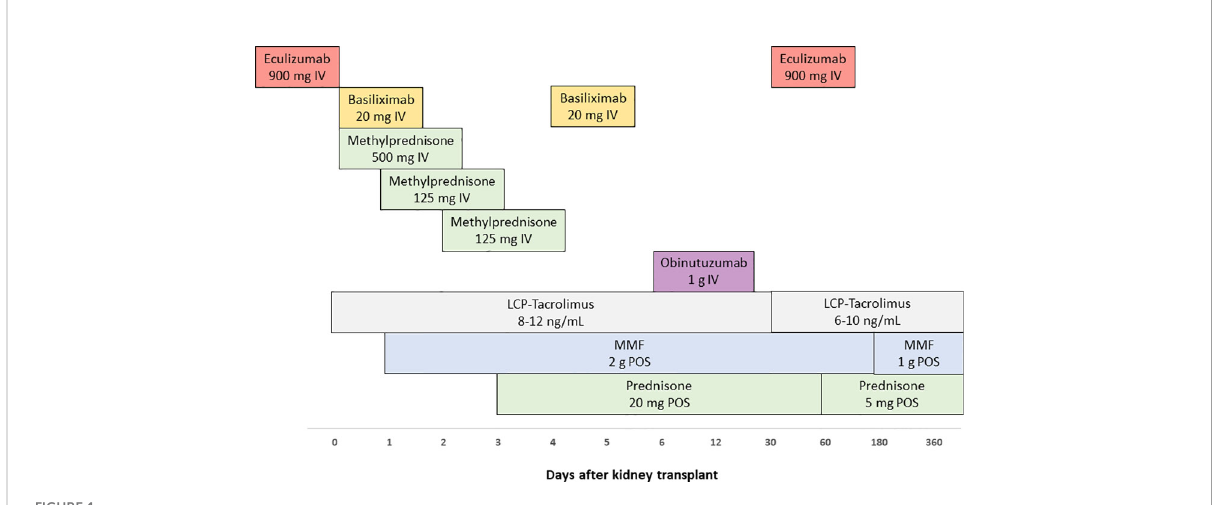
FIGURE 1 Detailed timeline of kidney transplant-related